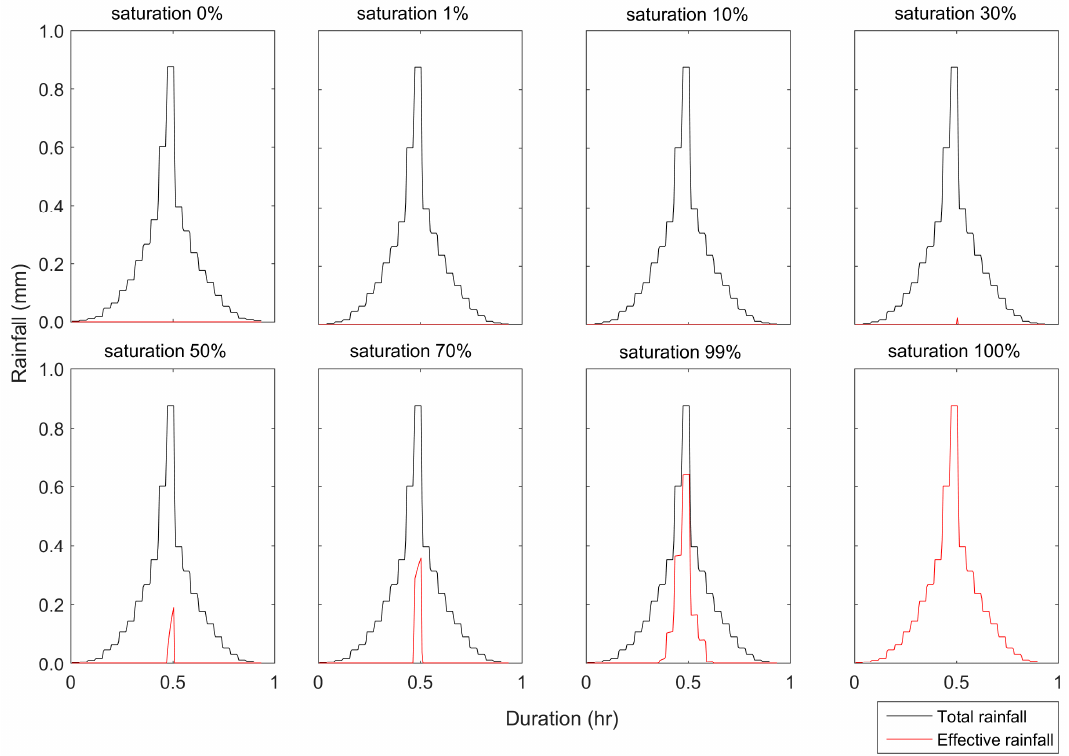
Figure 3. Simulated hyetograph for Sym01 for an event having a return period of 2 years, duration of ~1 h and cumulative rainfall of ~32.5 mm; the effective rainfall producing runoff for different antecedent moisture conditions is shown in red.